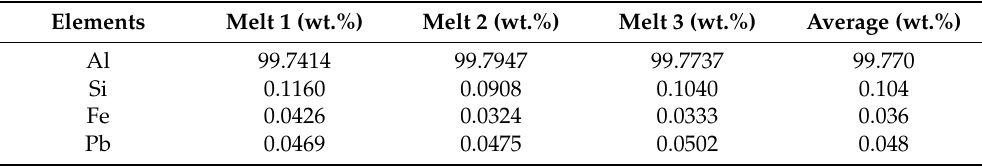
Table 2. Chemical composition of the starting alloy for the cast melts.